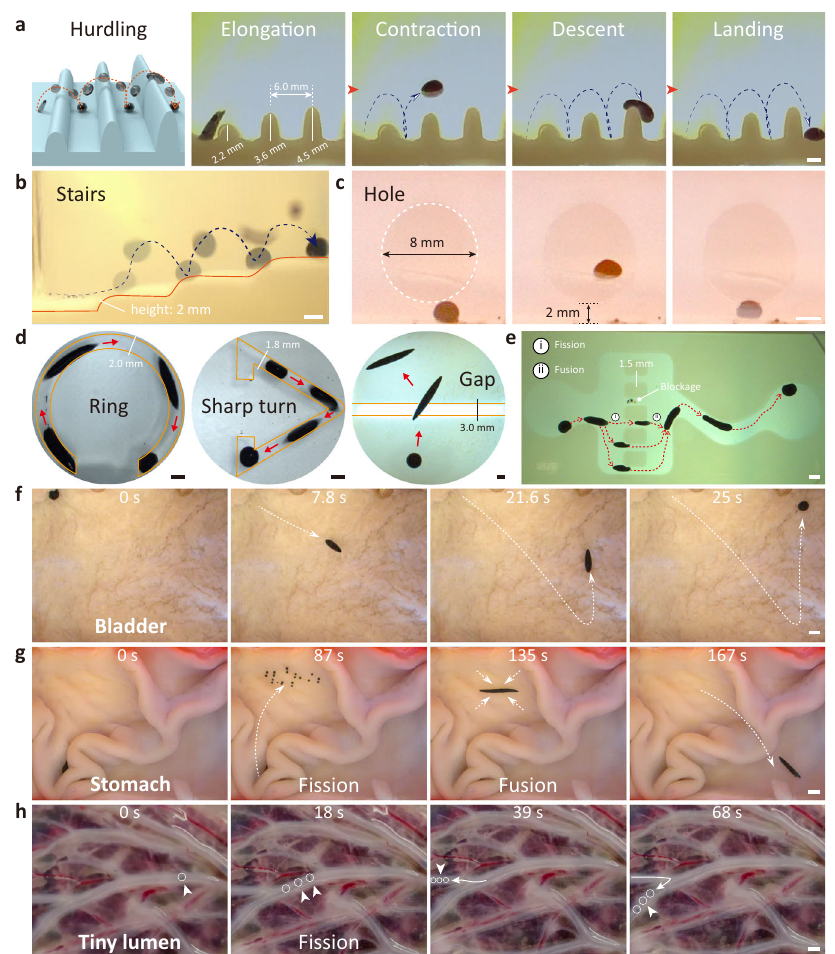
Fig. 4 | Multimodal locomotion, deformation and scale-recon fi guration over the complex environment. a Directional hurdling. The ferro fl uid droplet jumps over successive obstacles under a 1D oscillating magnetic fi eld (100 Hz, 9 mT). b Jumping up the stairs. c Jumping over designated holes in the wall. d The ferro- fl uid droplets adaptively deform and actively pass through a circularly curved channel, a sharp turn and a gap. e The ferro fl uid droplet utilizes splitting behavior